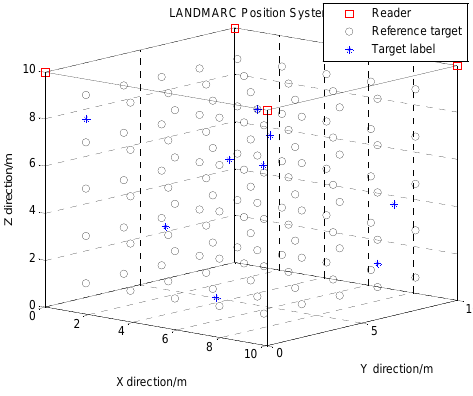
Figure 1. LANDMARC localization system layout.